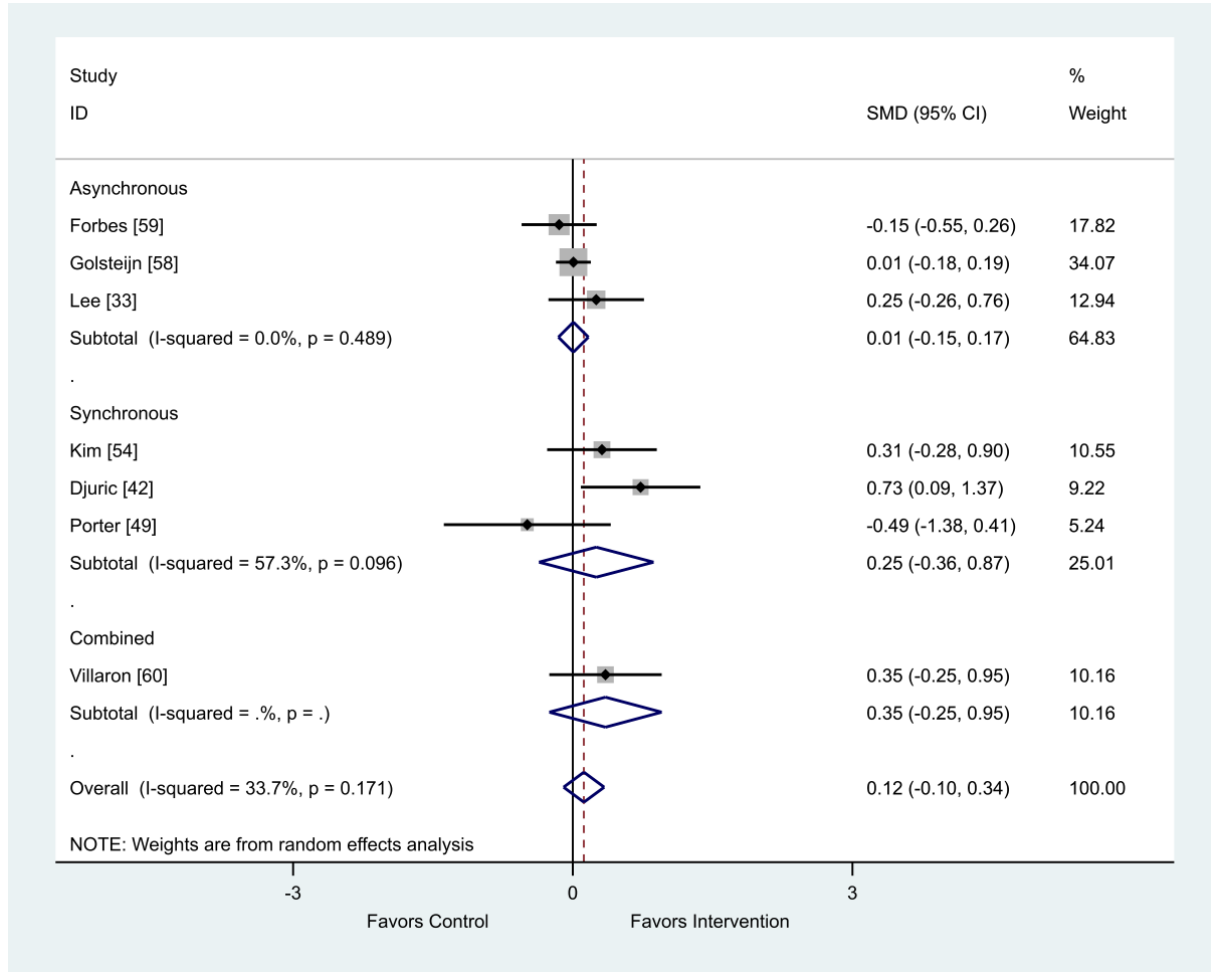
Figure 6. Effect of electronic health interventions compared with a control on quality of life interventions, analyzed using standardized mean difference (postintervention mean and SD). SMD: standardized mean